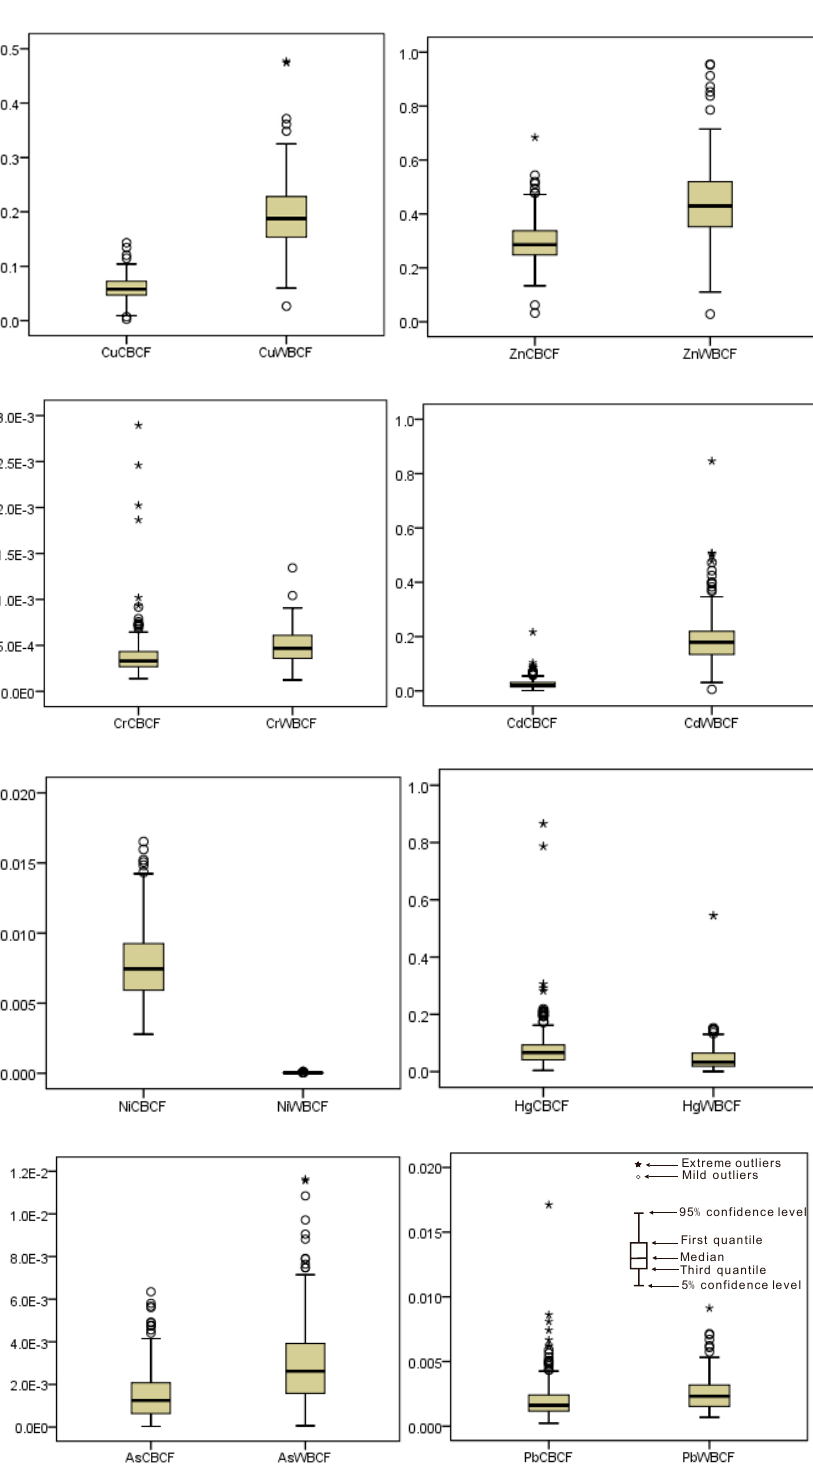
Figure 4. Box plot of metal(loid) accumulation in corn and wheat samples (CBCF and WBCF represent the bioconcentration factors (BCF) values for corn and wheat, respectively).